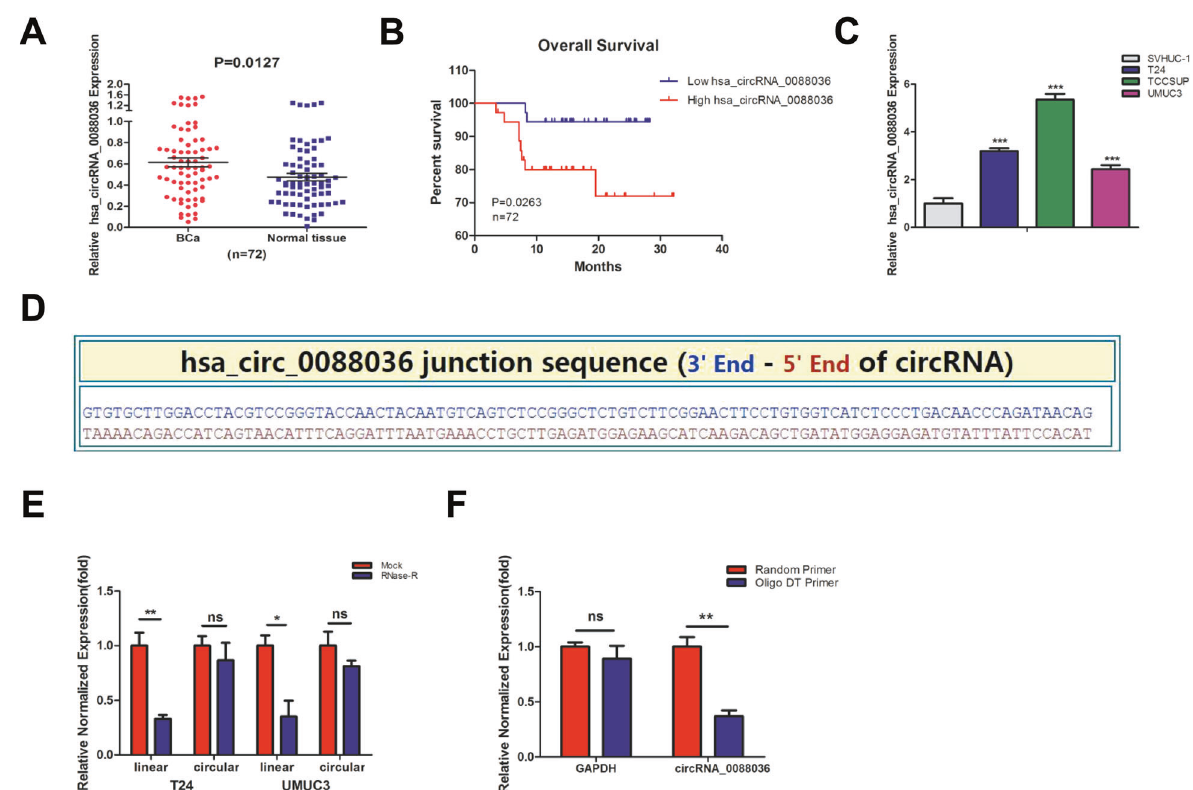
Fig. 1 The expression of hsa_circRNA_0088036, which has a closed-looped structure, is upregulated in BCa tissues and cell lines. A Hsa_circRNA_0088036 expression in 72 paired human BCa and adjacent normal bladder tissues. B OS curves of BCa patients were